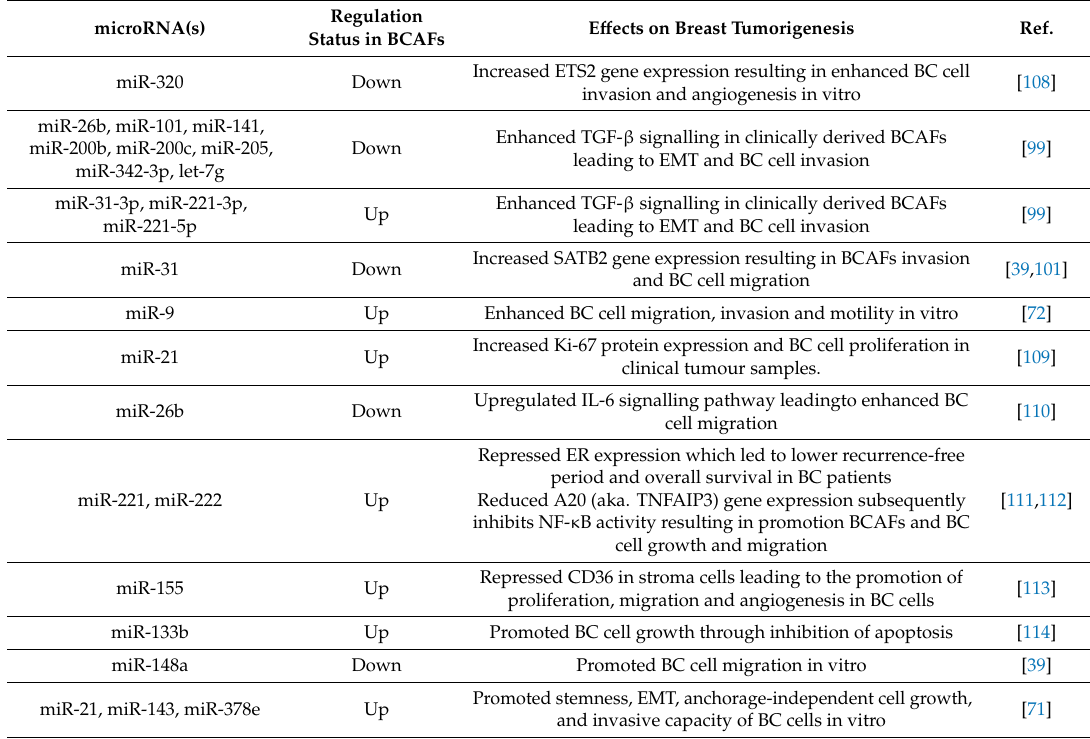
Table 3. Overview of miRNA dysregulation in BCAFs and its e ff ects on BC progression. Regulation microRNA(s) E ff ects on Breast Status in BCAFs